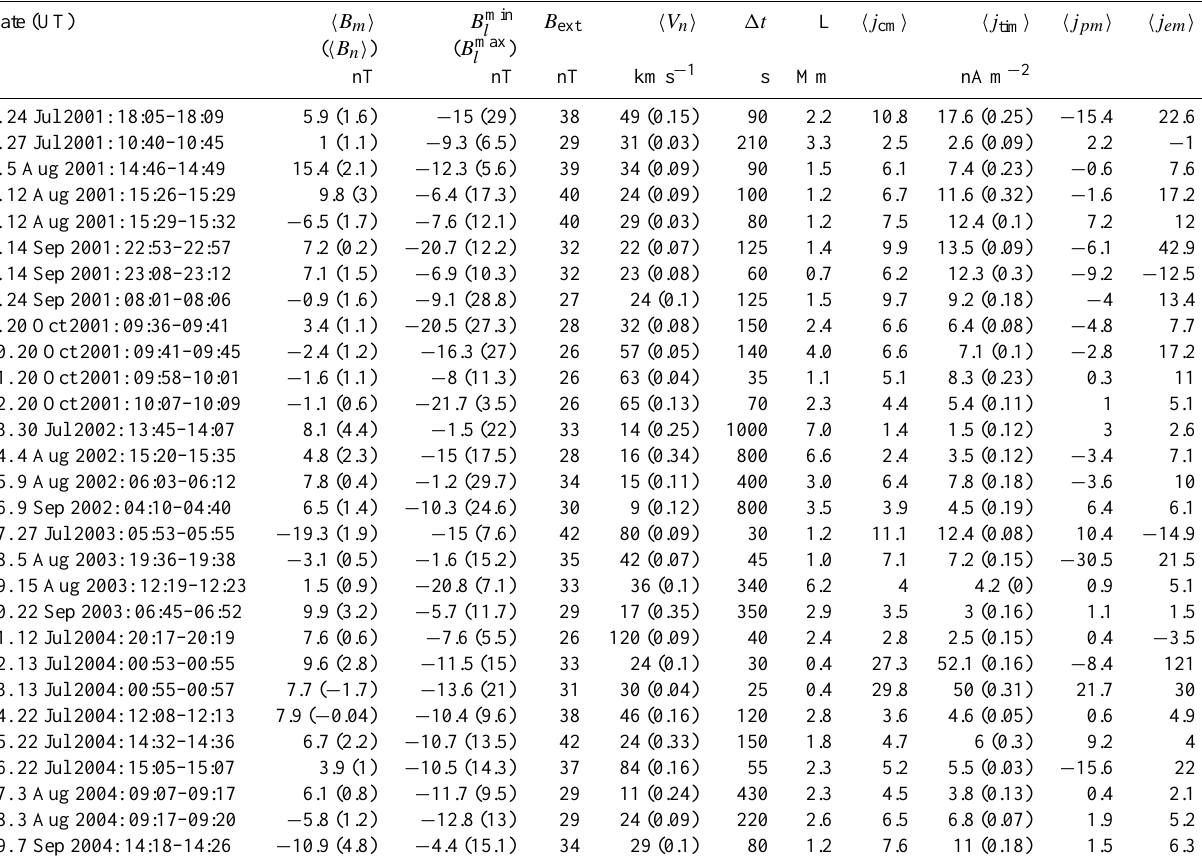
Table 1. List of events. In the rows presenting h V n i and h j tim i , the numbers in parentheses are root mean square deviations δV n / h V n i and δj tim / h j tim i . The CS thickness L is given in megameters, Mm=10 3